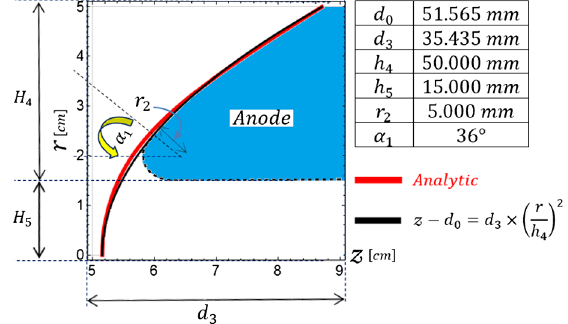
FIG. 6. Analytical geometry of 140 kV equipotential surface (the anode surface) in comparison with a nose (hatched region) composed of a curve, straight line and a part of a parabola.